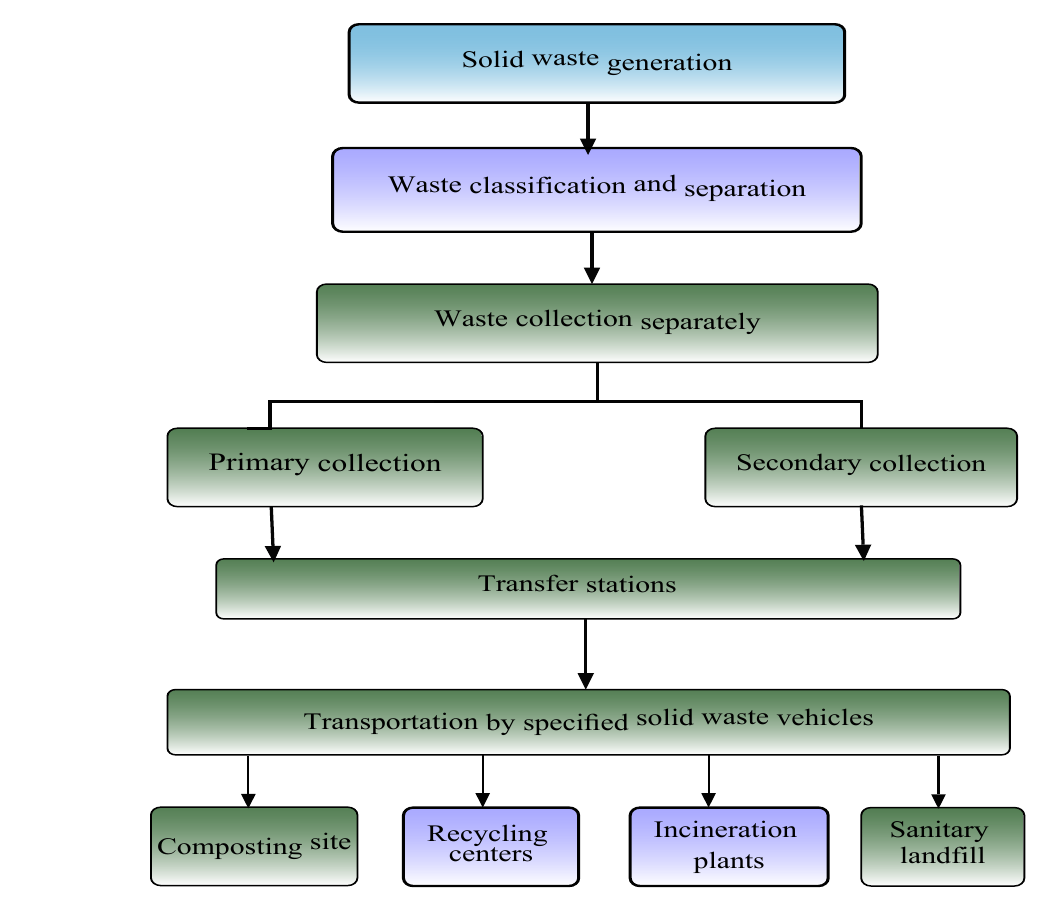
Figure 6. The Proposed Flow of the Solid Waste Organization Scheme in Addis